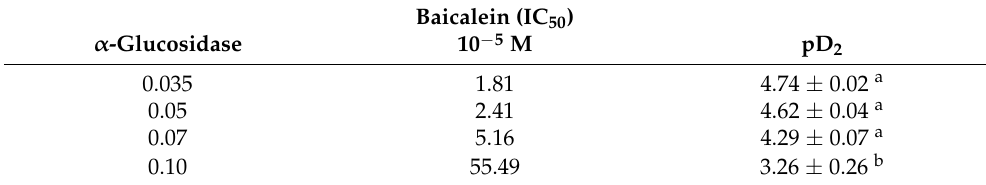
Table 1. Inhibitory potency of baicalein with four different α –glucosidase concentrations. Baicalein (IC 50 ) α -Glucosidase